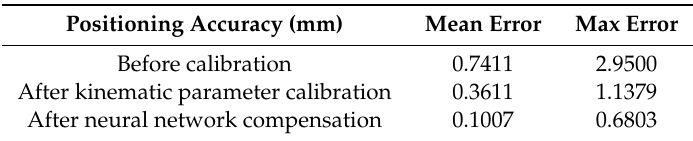
Table 1. Positioning accuracy of the simulations.